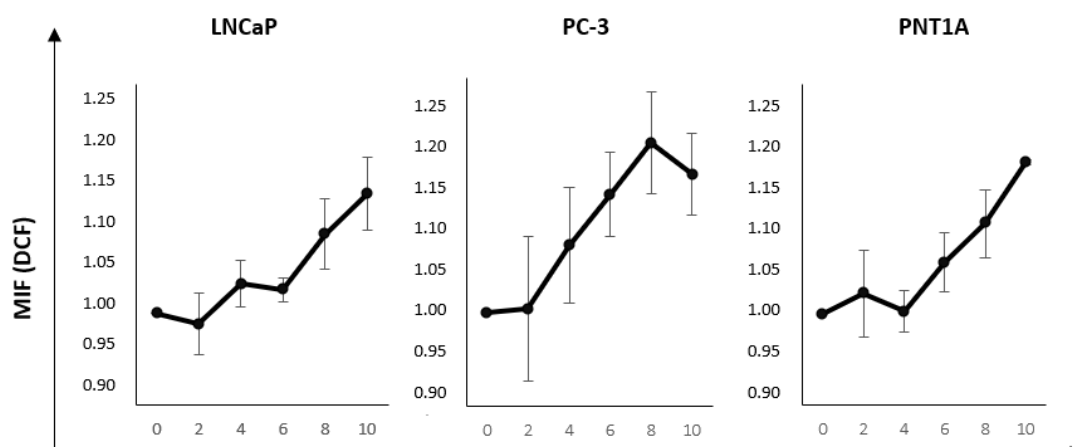
Figure 5. Results of reactive oxygen species in cells after incubation with nanorods. Mean fluorescence intensity (MIF) parameter determined the number of reactive oxygen species (ROS) generated depending on the nanorods concentration in the LNCaP cell line after 6 h incubation, PC-3 cell line after 4 h incubation, and PNT1A cell line after 4 h incubation. The values presented in the graph are the mean of the obtained results, and the deviation is the standard deviation. The experiment was performed in triplicate.